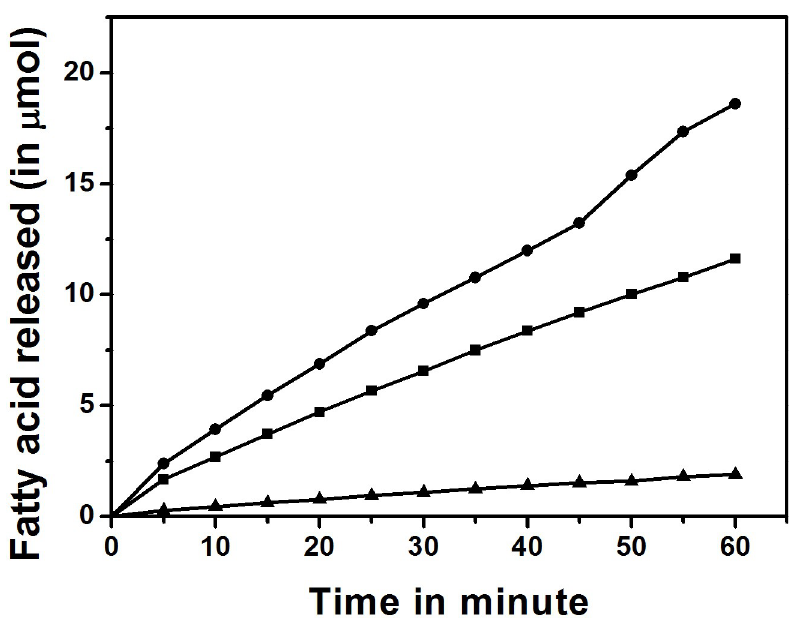
Fig 8. Activity of GTL and mutants with anchovy oil as substrate. Activity monitored by a pH Stat method. GTL (circle), DM-GTL (square) and CM-GTL (triangle).